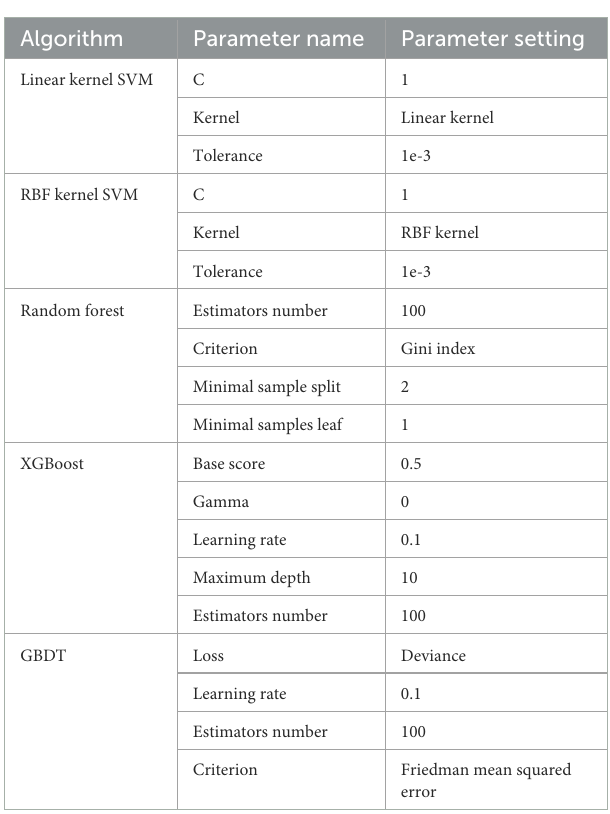
TABLE 2 Details of the parameters of the used machine learning